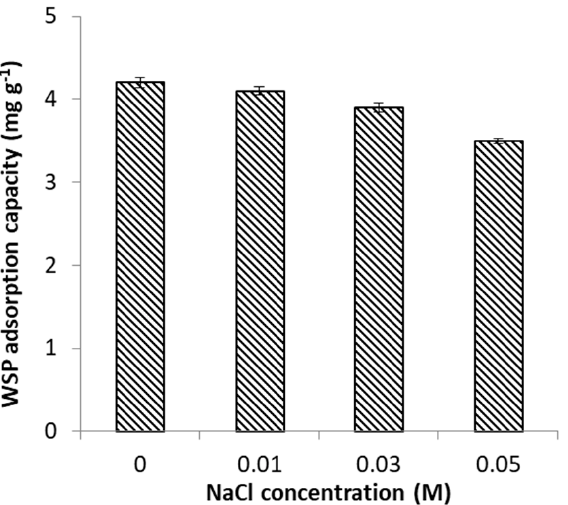
Figure 8. Effect of ionic strength on Fe II adsorption capacity of WSP.